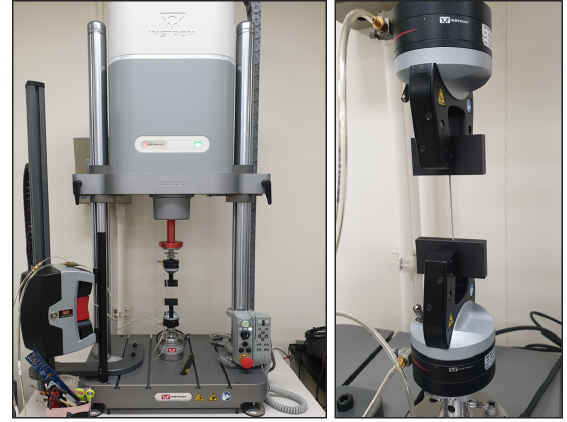
Figure 3. Cyclic tensile test of PDMS films.